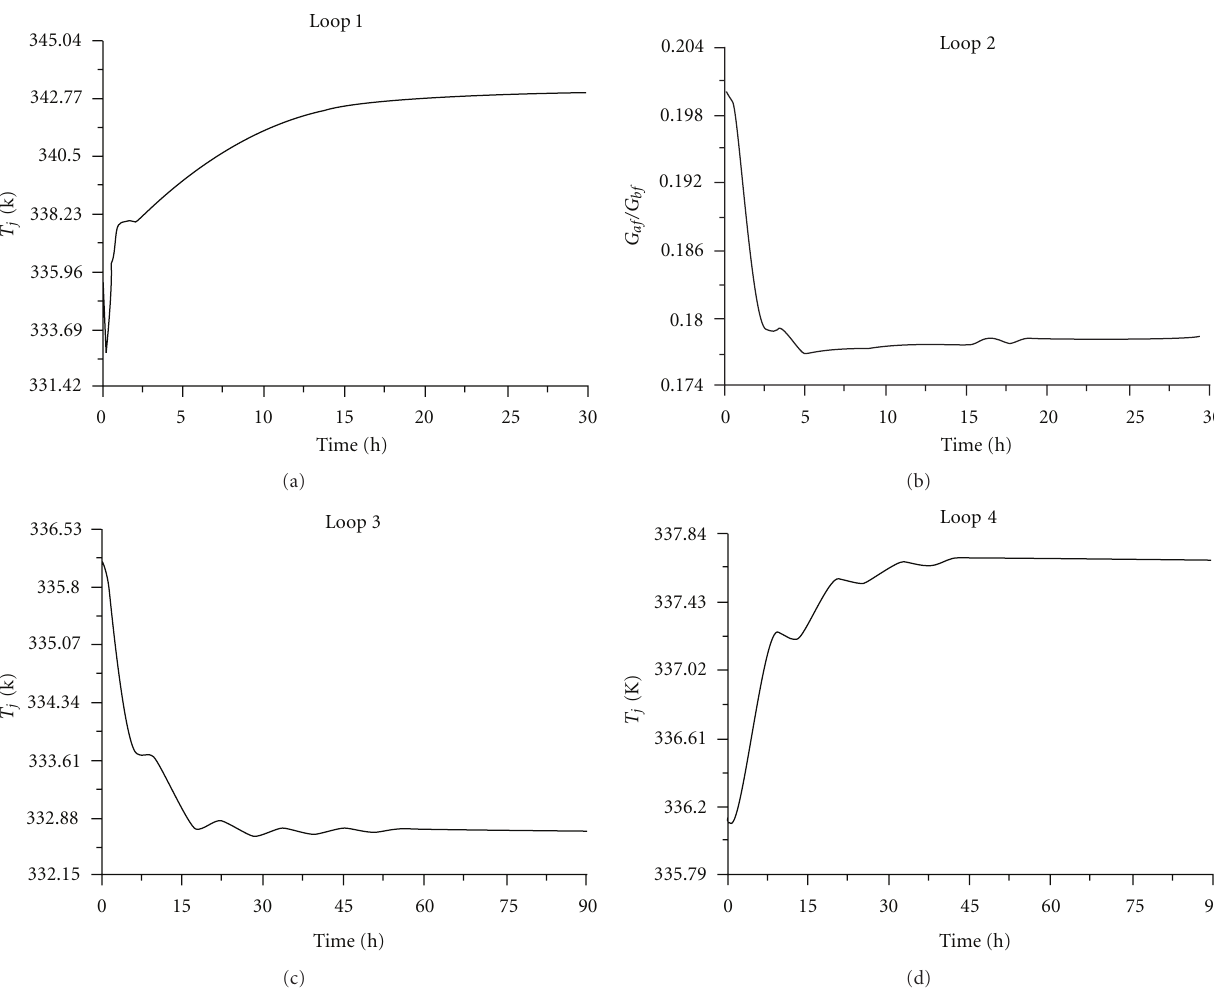
Figure 6: Manipulated variables profile for an inhibitor disturbance of 4 parts per 1000 (mole